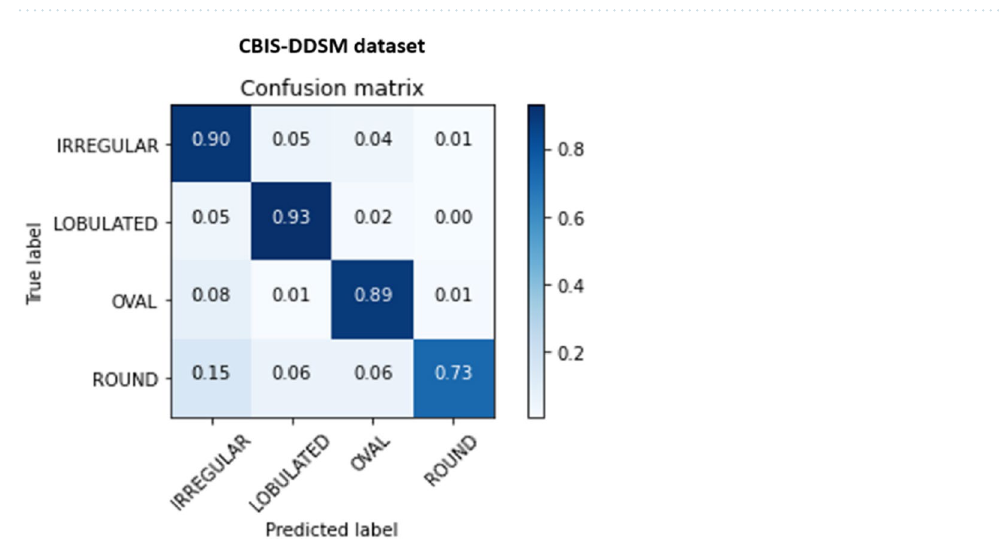
Figure 11. Confusion matrix of the stacked ensemble of models for the Shape classification on the mammography